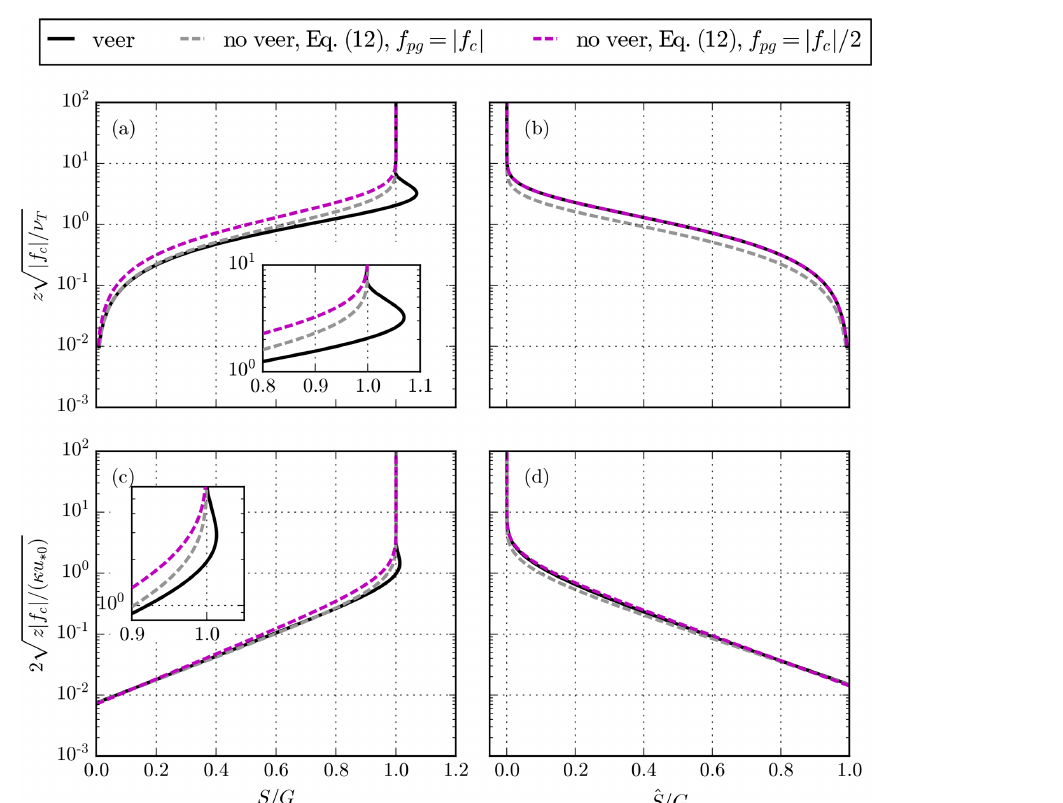
Figure 1. Analytic solutions with and without wind veer. (a, b) Constant ν T . (c, d) Linear ν T and Ro 0 = 10 5 . (a, c) Wind speed. (b, d) Ageostrophic wind